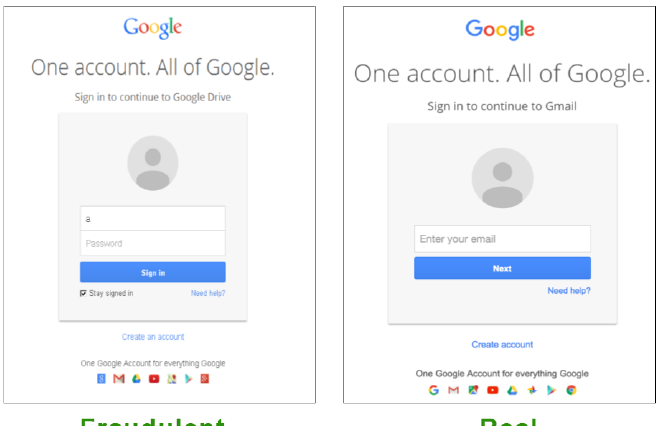
Figure 2. Example of phishing of the Google login page (source: https://images.google.com/, accessed on 10 August